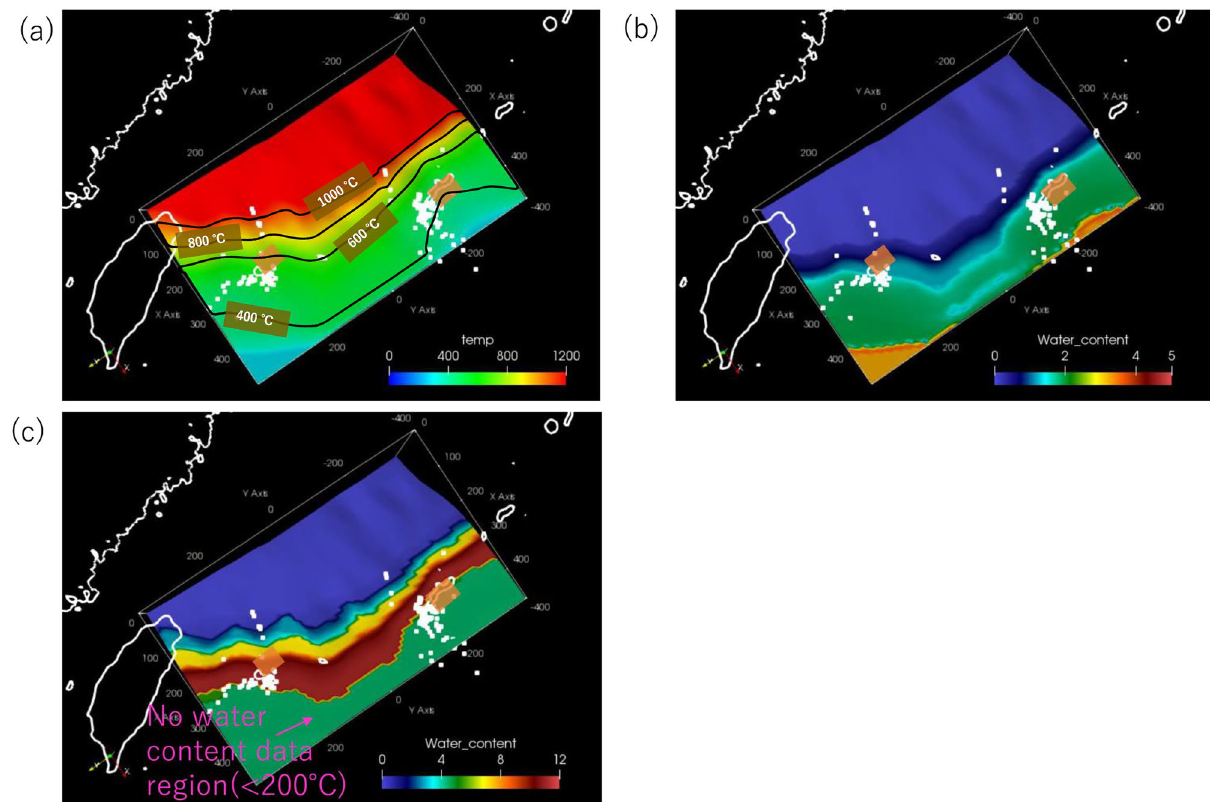
Figure 3. ( a ) Calculated temperature (°C) at the upper surface of the PHS plate for the best-fit model to the observed heat flow data, as viewed from the top. The orange-shaded rectangular areas denote the fault planes of S-SSEs 2 during the period from 1 January 1997 to 10 November 2013. The white-solid squares denote epicentres of LFEs 3 during the period from 1 April 2004 to 31 December 2016. The black solid lines denote isothermal contours on the upper surface of the PHS plate. ( b ) Estimated water-content (wt%) distribution obtained using the phase diagram of the hydrous MORB at the surface of the PHS plate for the best-fit model. The others are the same as in ( a ). ( c ) Estimated water-content (wt%) distribution obtained using the phase diagram of hydrous ultramafic rock at a depth of 5 km above the surface of the PHS plate for the best-fit model. The others are the same as in ( a